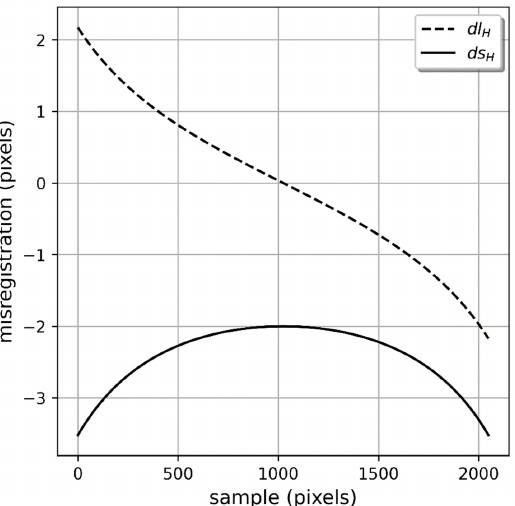
Figure 3. Theoretical misregistration in along-scan and along-track direction between band 1 and band 8 according to the design. band 8 according to the